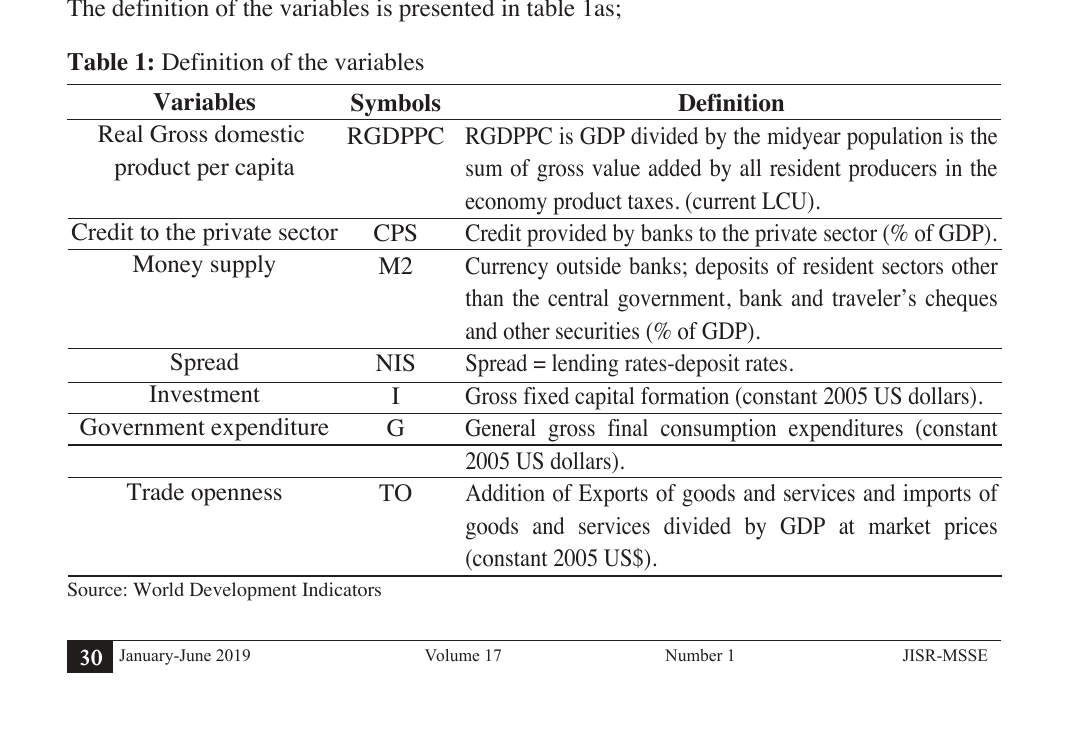
Table 1: Definition of the variables